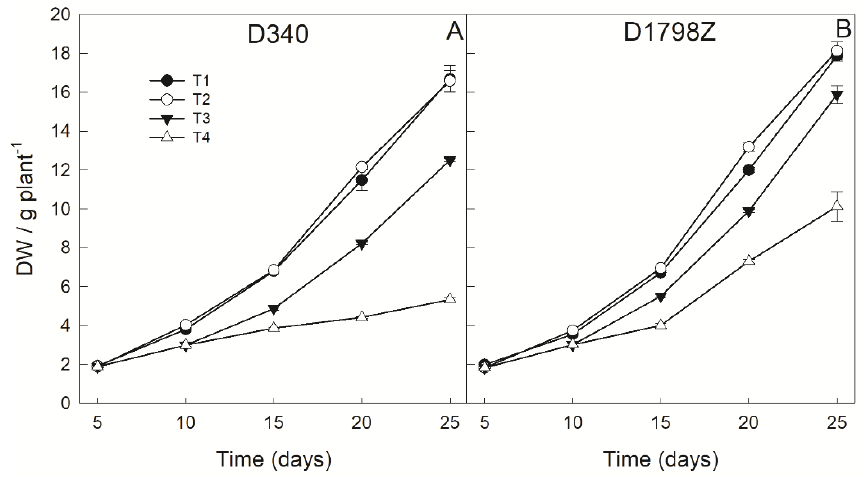
Figure 2. E ff ect of di ff erent drought durations and re-watering on dry weight (DW) of two maize lines. Figure 2. Effect of different drought durations and re-watering on dry weight (DW) of two maize Each parameter is the average of three lines. Each parameter is the average of three replicates.